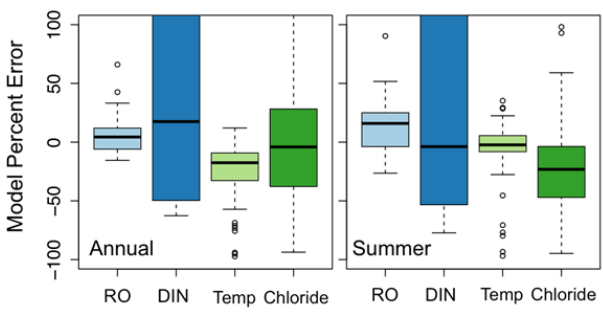
Fig. 3. Box plots of model percent error (MPE) across all sites (MPE = (P-O) / O * 100) for aquatic variables during annual (a) and summer (b) time periods (RO: Runoff; DIN: Dissolved Inorganic Nitrogen, Temp: Water Temperature; where, P is the predicted values by the model and O is the observed values at different sampling sites).